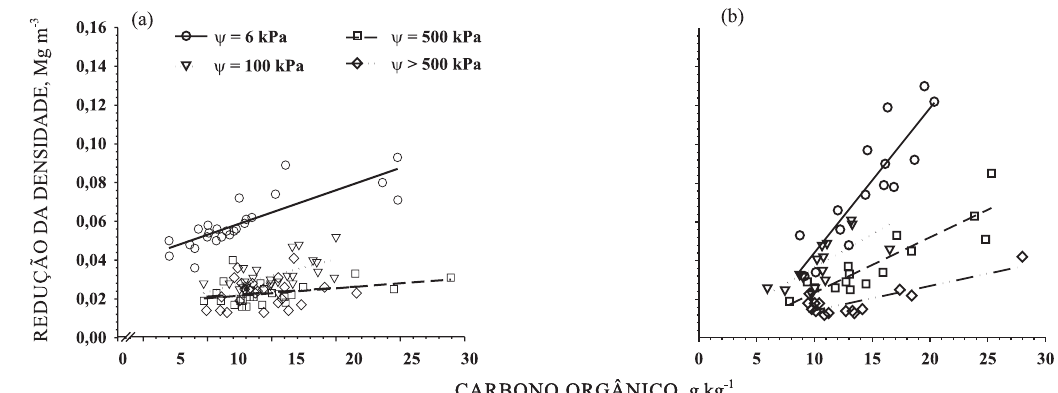
Figura 5. Redução da densidade após o descarregamento do solo em função do teor de carbono orgânico para um Nitossolo Vermelho distrófico latossólico (a) e para um Argissolo Vermelho-Amarelo distrófico arênico (b), submetidos a quatro tensões de água ( ψψψψψ